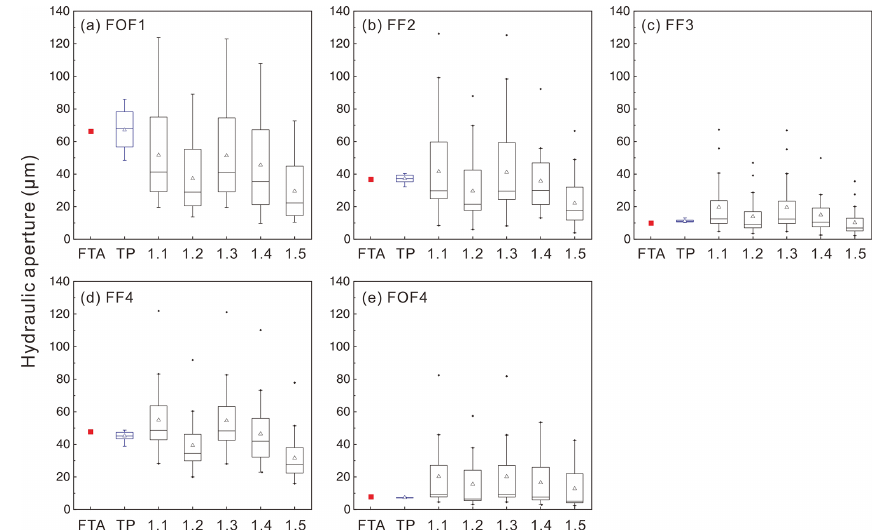
Figure 9. Comparison of hydraulic apertures measured with the flow-through apparatus (FTA; red squares) and the transient-airflow perme- ameter (TP; blue box plot) and derived from MC-measured mechanical apertures (1.1 to 1.5; black box plots) using the empirical equations 1 to 5 listed in Table 1. Individual symbols (black dots) above the whiskers are calculated data but represent statistical